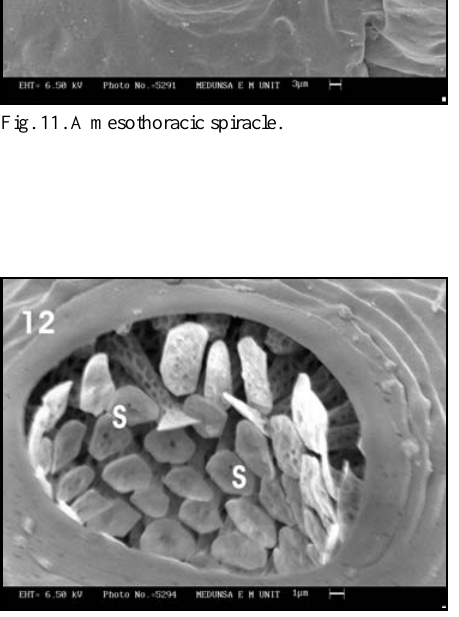
Fig. 12. The spiracular lumen lined with pedunculat- ed irregular pentagonally shaped scales